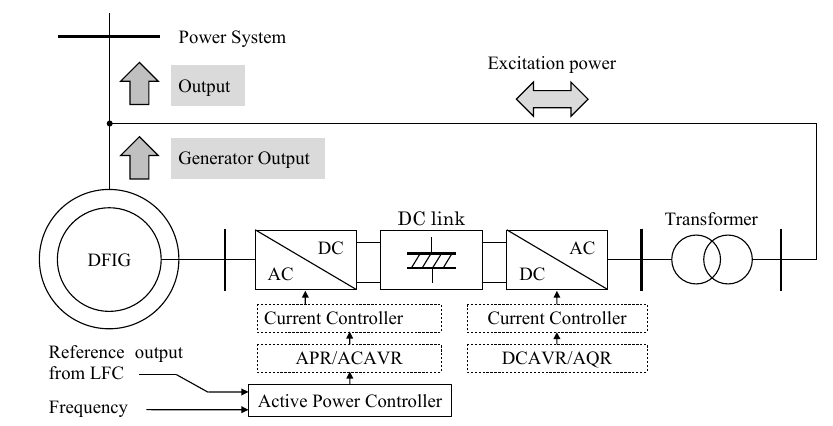
Figure 4. Automatic voltage regulator for the conventional FS-SG.